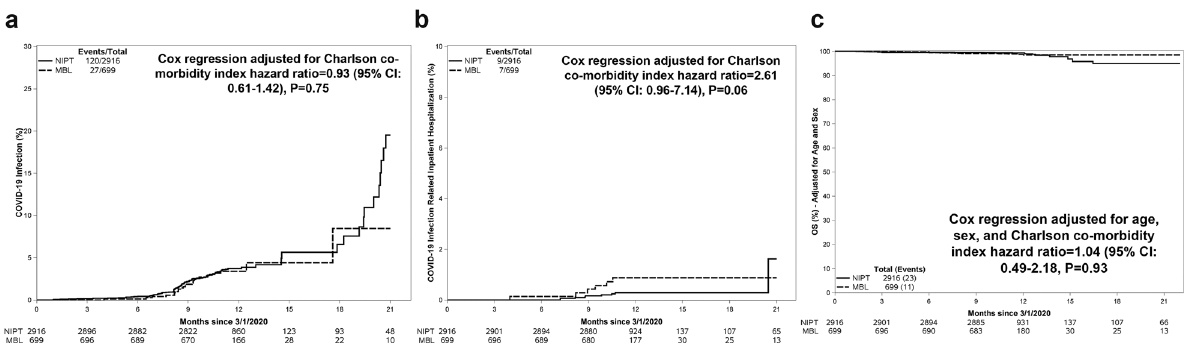
Fig. 1 Cumulative incidence of SARS-CoV-2 infection, hospitalization due to COVID-19, and overall survival among individuals with monoclonal B cell lymphocytosis (MBL) compared to those without MBL (i.e., with normal immunophenotype [NIPT]). a Cumulative incidence of contracting SARS-CoV-2 adjusted for the competing risk of death in individuals with monoclonal B cell lymphocytosis (MBL) compared to individuals without MBL (normal immunophenotype [NIPT]). b Cumulative incidence of COVID-19 infection-related hospitalizations adjusted for the competing risk of death among subjects with monoclonal B cell lymphocytosis (MBL) compared to individuals without MBL (normal immunophenotype [NIPT]). c Overall survival of all study participants grouped according to monoclonal B cell lymphocytosis (MBL) or no MBL (normal immunophenotype [NIPT]) at study